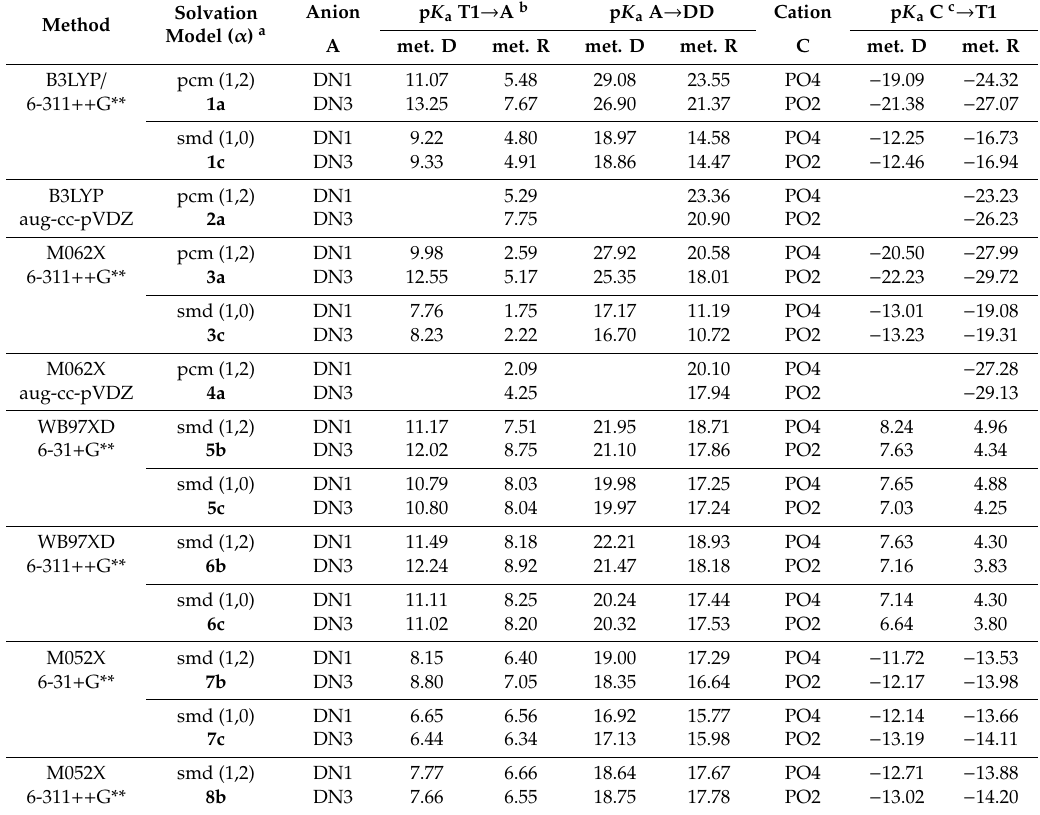
Table 6. The p K a values for acidic equilibria of 5FU concerned the T1 tautomeric form.